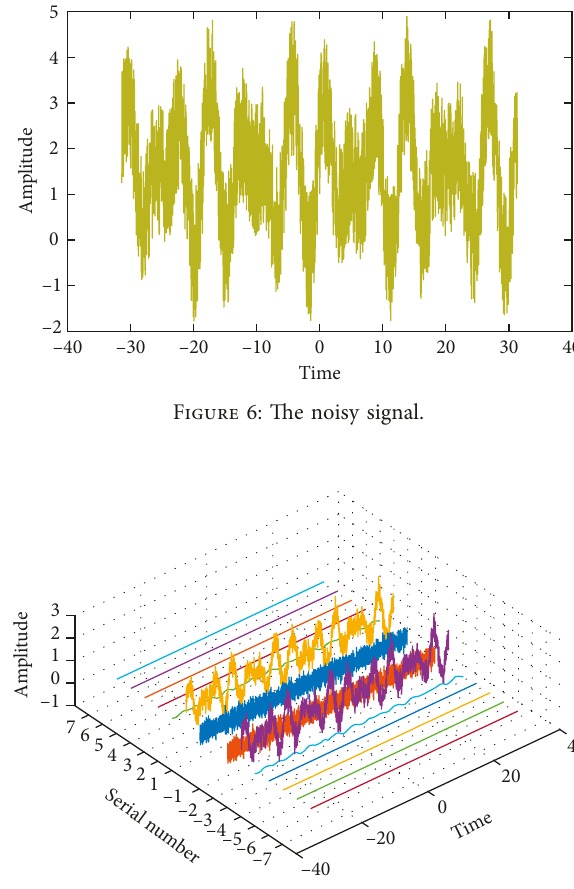
Figure 7: The real part of the signals in the time domain.